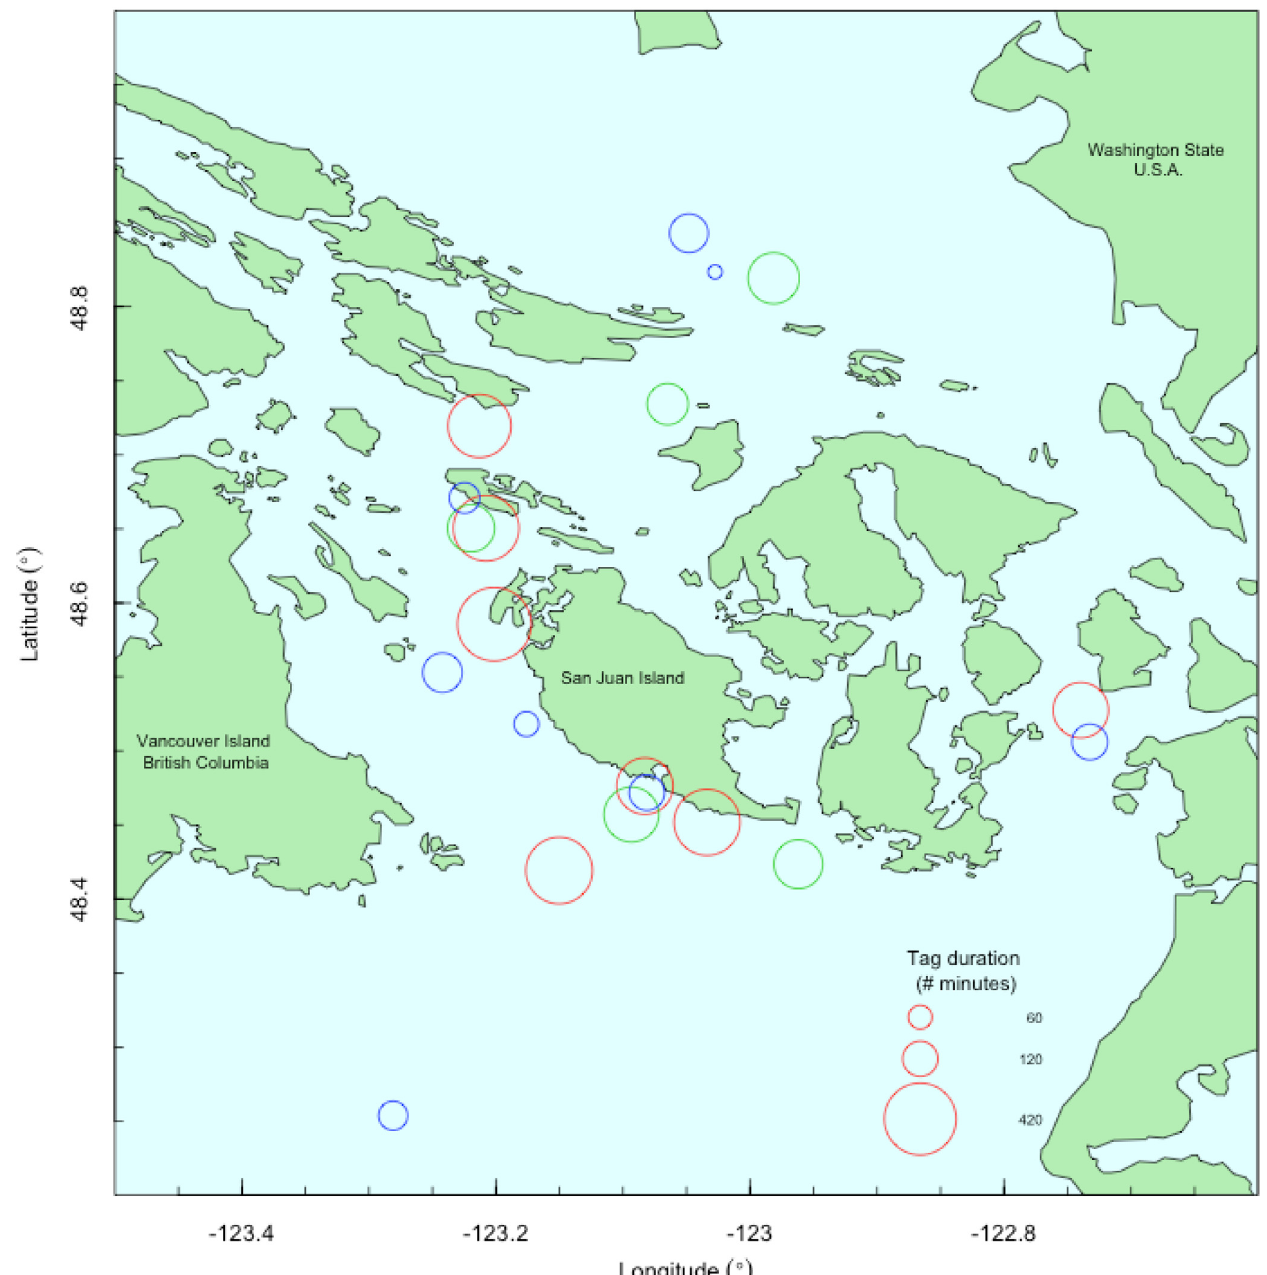
Fig 1. Locations of tag deployments. Locations of tag deployments during which vessel data were collected concurrently (n = 20). The color of the ring corresponds to the year as follows: 2010 – red, 2011 – green, 2012 – blue. The size of the ring depicts the duration of the tag deployment in minutes. The tagged whale travelled beyond the area designated by the ring throughout the deployment